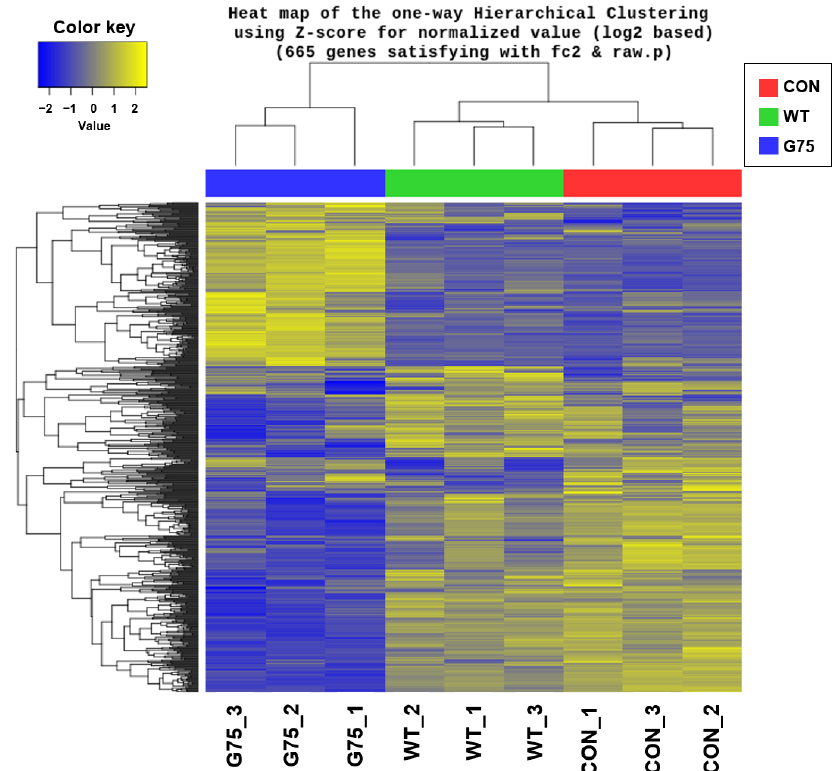
Figure 3. Hierarchical clustering of differentially expressed genes (DEGs) in HT-29 cells stimulated by wild-type spores (WT) or CotG-p75 (G75) compared to control (CON). Each row represents one of the common genes, and each column represents each sample. The color scale means gene expression standard deviations from the mean represented as Z-score. Yellow indicates up-regulation, and blue indicates down-regulation.